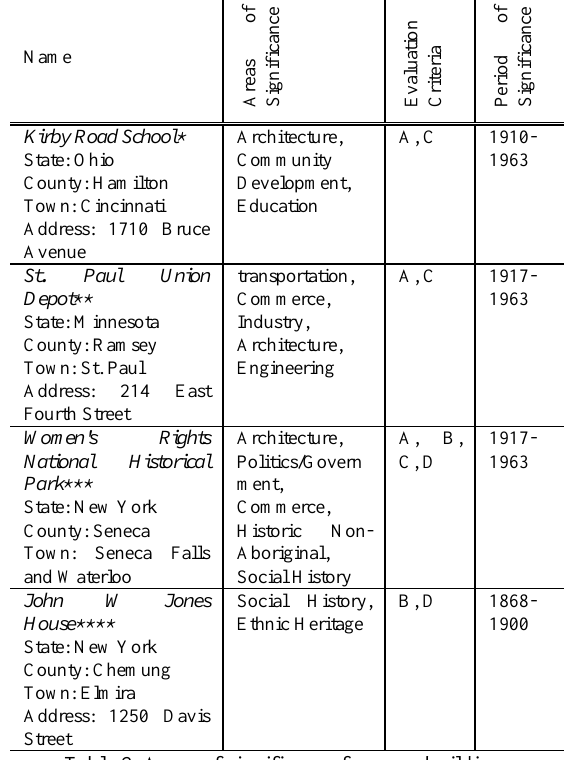
Table 2. Areas of significance for some buildings Sources: * NRHP. NPS Form 10-900, Kirby High